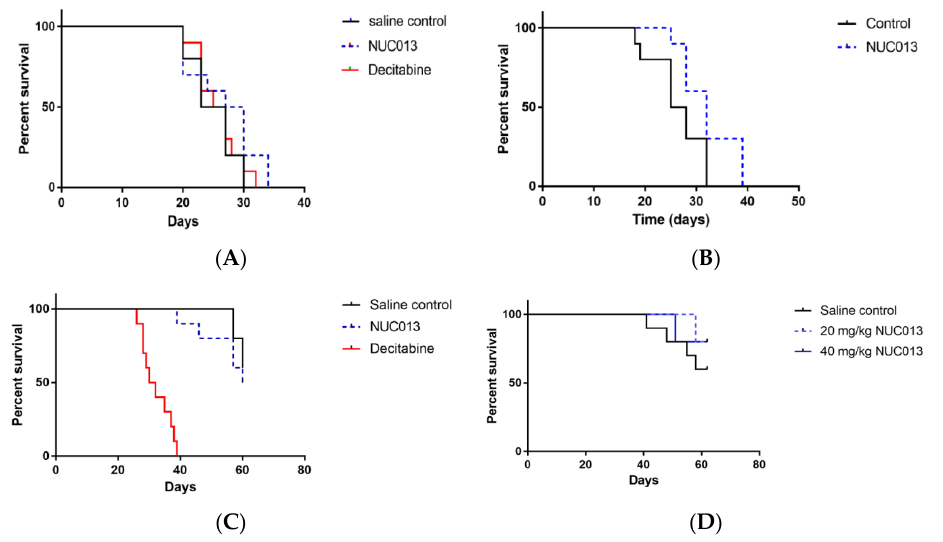
Figure 3. Survival proportions in HL-60 and LoVo xenografts treated with decitabine or NUC013 ( n = 10/group). “Survival” refers to animals that were not removed from the study by death or per protocol euthanasia. ( A ) Survival proportion in HL-60 xenografts. Saline control compared to decitabine (5 mg/kg) and NUC013 (5.8 mg/kg). Saline median survival (MS) = 25 days, decitabine MS = 26 days, and hazard ratio (HR) = 0.92 ( p = 0.64, Log-rank test); NUC013 MS = 28.5 days and HR = 0.59 ( p = 0.19, Log-rank test); ( B ) Survival proportion in HL-60 xenografts. Saline compared to NUC013 (20 mg/kg). Saline MS = 26.5 days, NUC013 MS = 32 days and HR = 0.26 ( p = 0.032, Log-rank test); ( C ) Survival proportion in LoVo xenografts. Saline control compared to decitabine (5 mg/kg) and NUC013 (5.8 mg/kg). Saline MS undefined, decitabine MS = 31 days and HR of 26.89 ( p < 0.0001, Log-rank test); NUC013 MS = 60 days and HR = 1.64 ( p = 0.48); ( D ) Survival proportion in LoVo xenografts. Saline control compared to 20 mg/kg and 40 mg/kg NUC013. MS undefined.